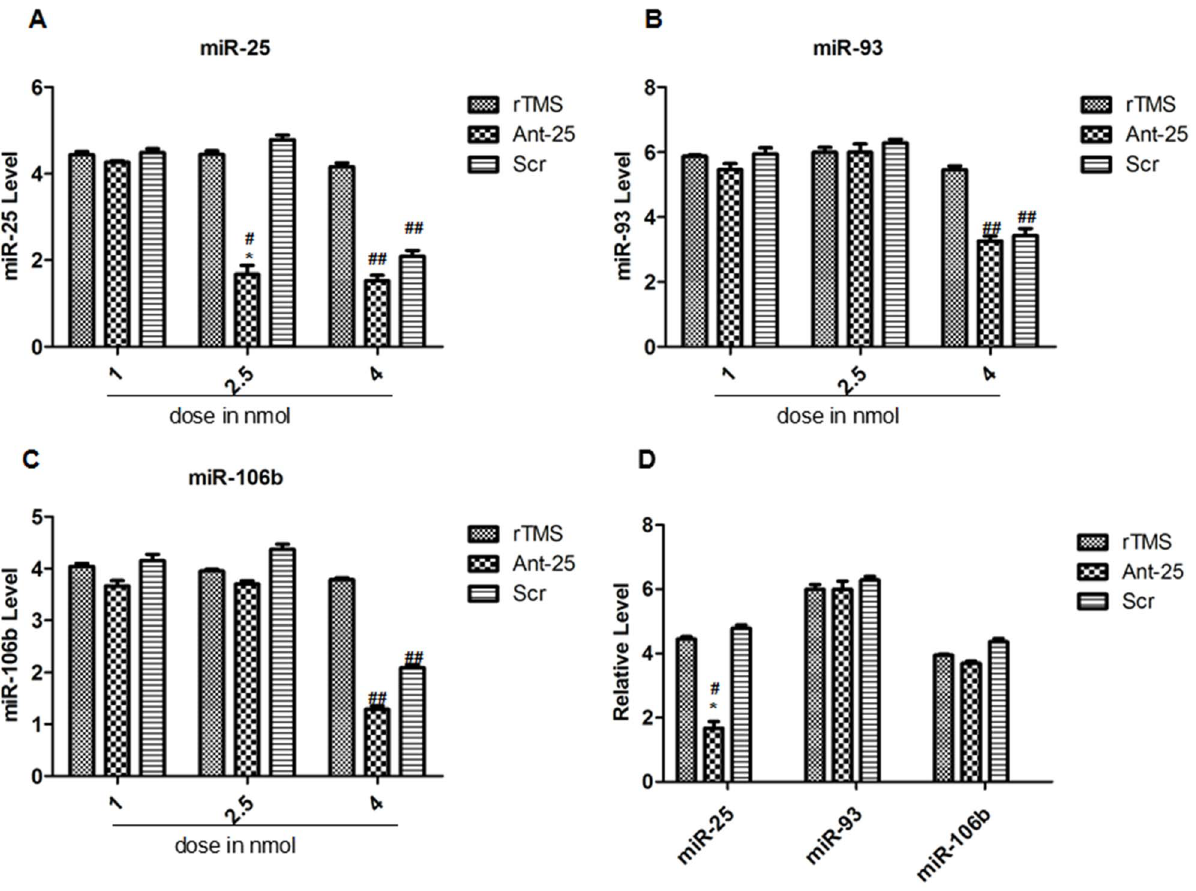
Figure 7. Effects of Ant-25 and Scr on miR-106b , 25 in the ipsilateral cortex 7 days after surgery. ( A – C ) A ) miR-93, B ) miR-106b and C ) miR-25 levels in the ischemic cortex after ICV injection of 1 nmol, 2.5 nmol and 4 nmol of Ant-25 or Scr. (D) qRT-PCR measurement of the miR- 106b , 25 cluster in the ischemic cortex after ICV injection of 2.5 nmol of Ant-25 or Scr. # P , 0.001 for 2.5 nmol compared to the rTMS group; * P , 0.001 for 2.5 nmol compared to the Scr group. ## P , 0.001 for 4 nmol compared to the rTMS group.